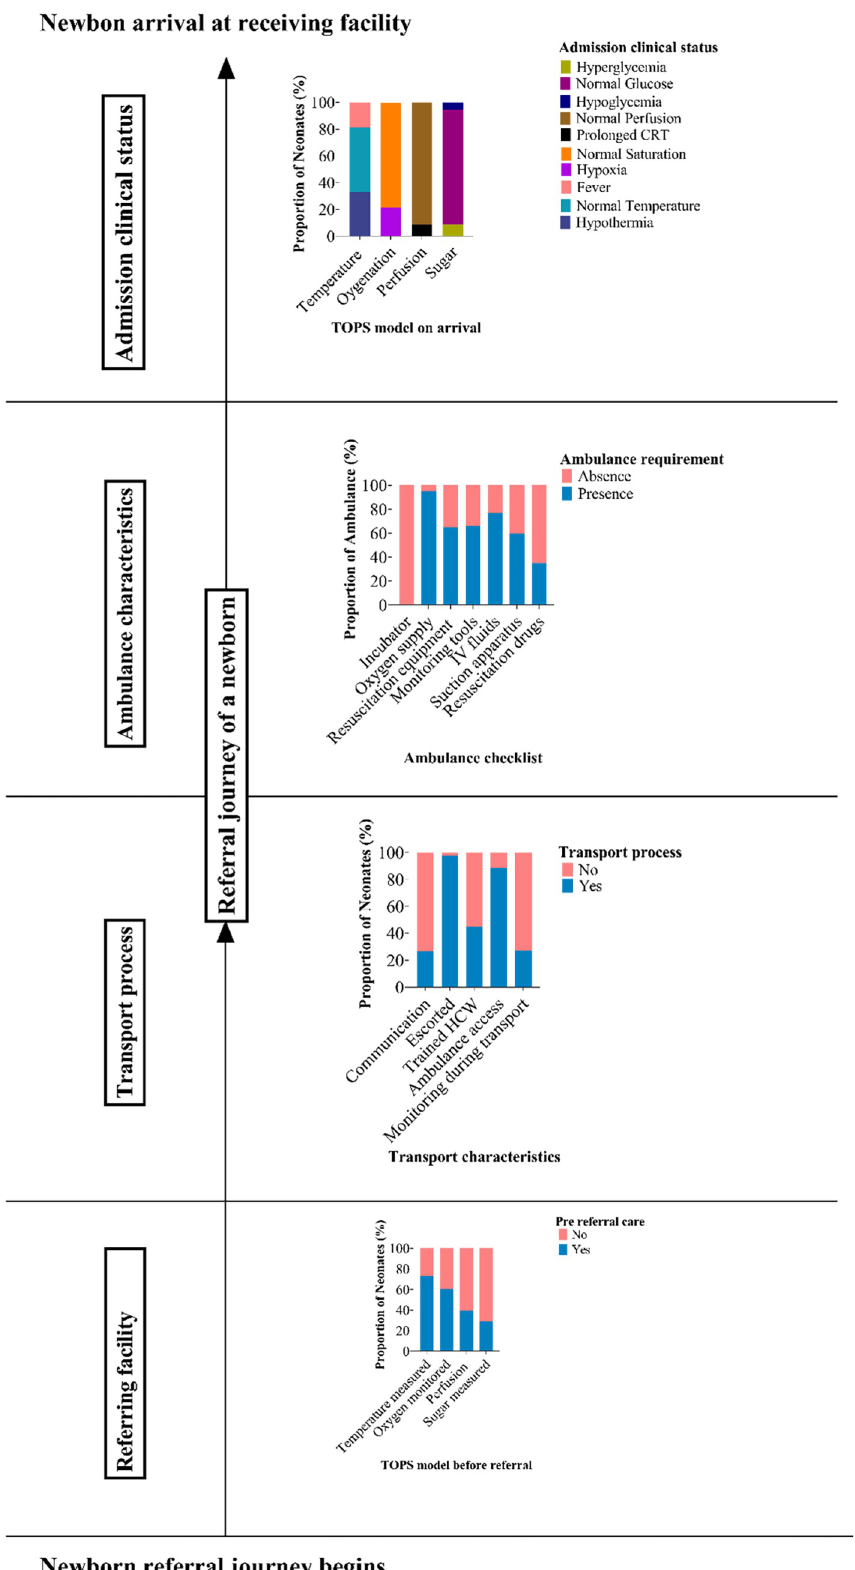
Fig 2. Coverage gap during the referral journey of a newborn in Dar es Salaam, Tanzania. https://doi.org/10.1371/journal.pone.0269479.g002 PLOS ONE | https://doi.org/10.1371/journal.pone.0269479 June 15,